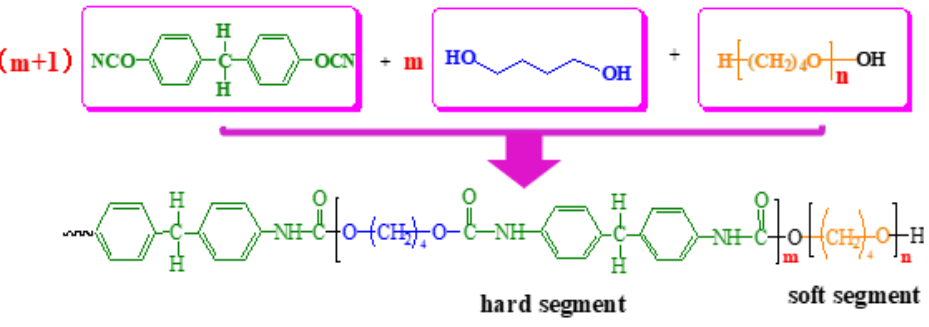
Figure 8. Chemical equation of MDI, BDO and PTMEG synthetize polyether-based TPUs.